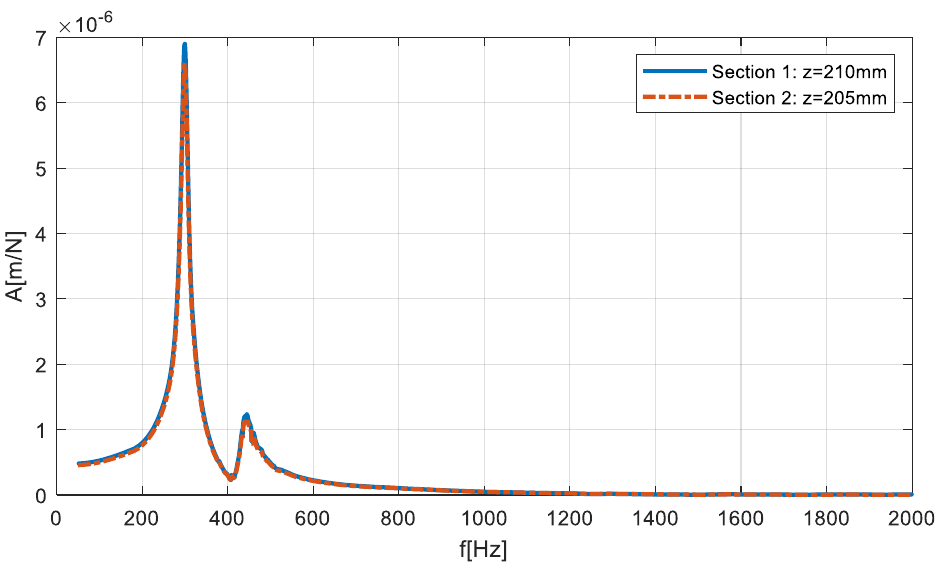
Figure 11. FRFs comparison of the considered sections.